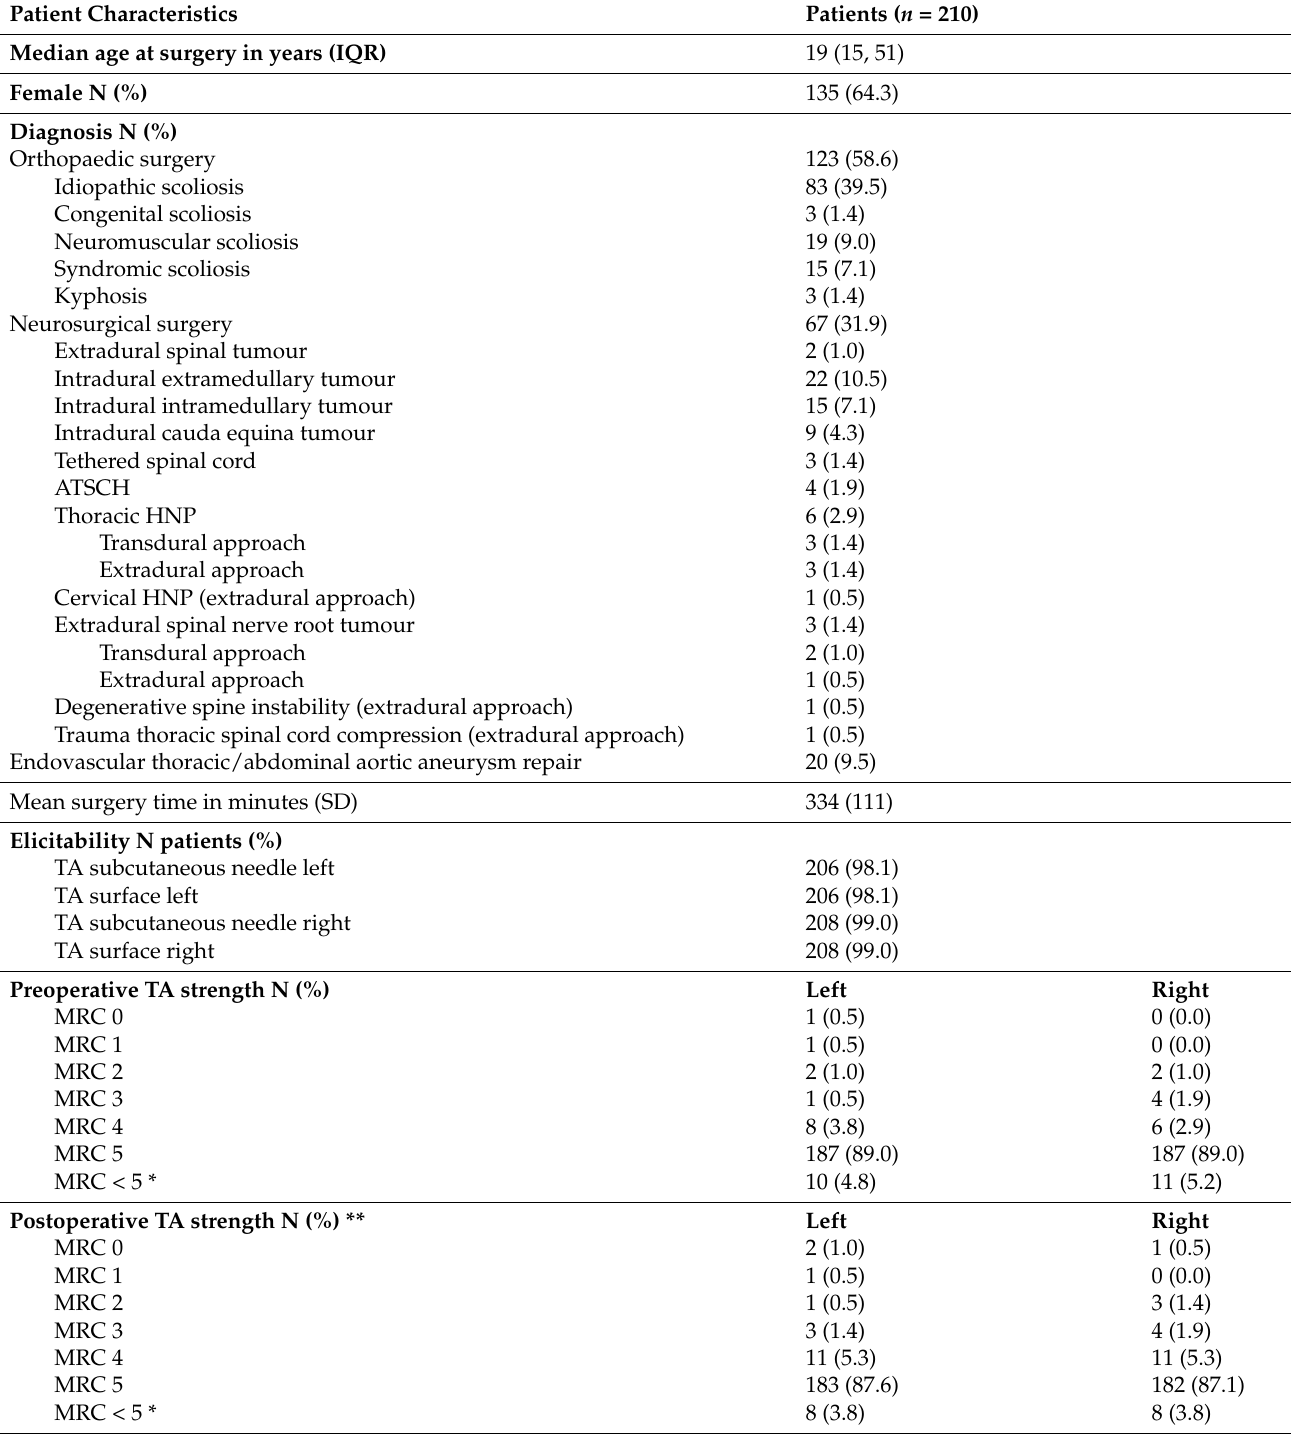
Table 2. Patient